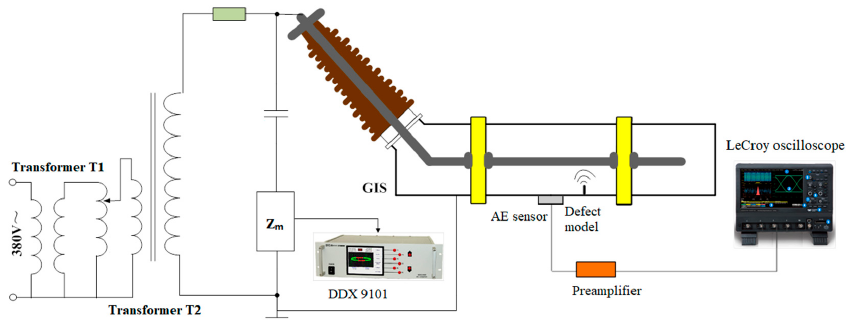
Figure 3. The detection system of insulation defects of GIS.